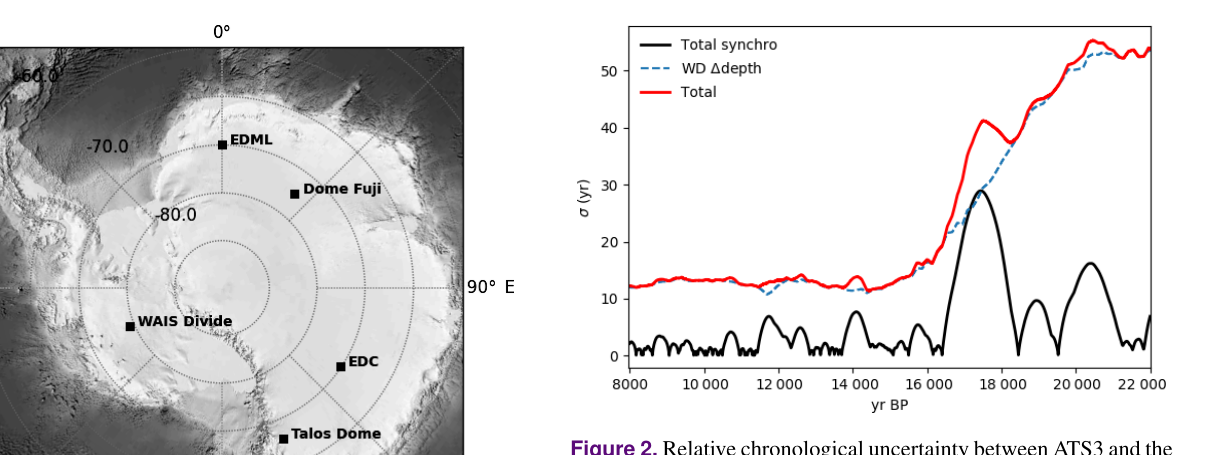
Figure 2. Relative chronological uncertainty between ATS3 and the WD CO 2 record (red line) calculated as the quadratic sum of the synchronization error from Buizert et al. (2018) (black line) and the (cid:49) age uncertainty from WD2014 (dashed blue